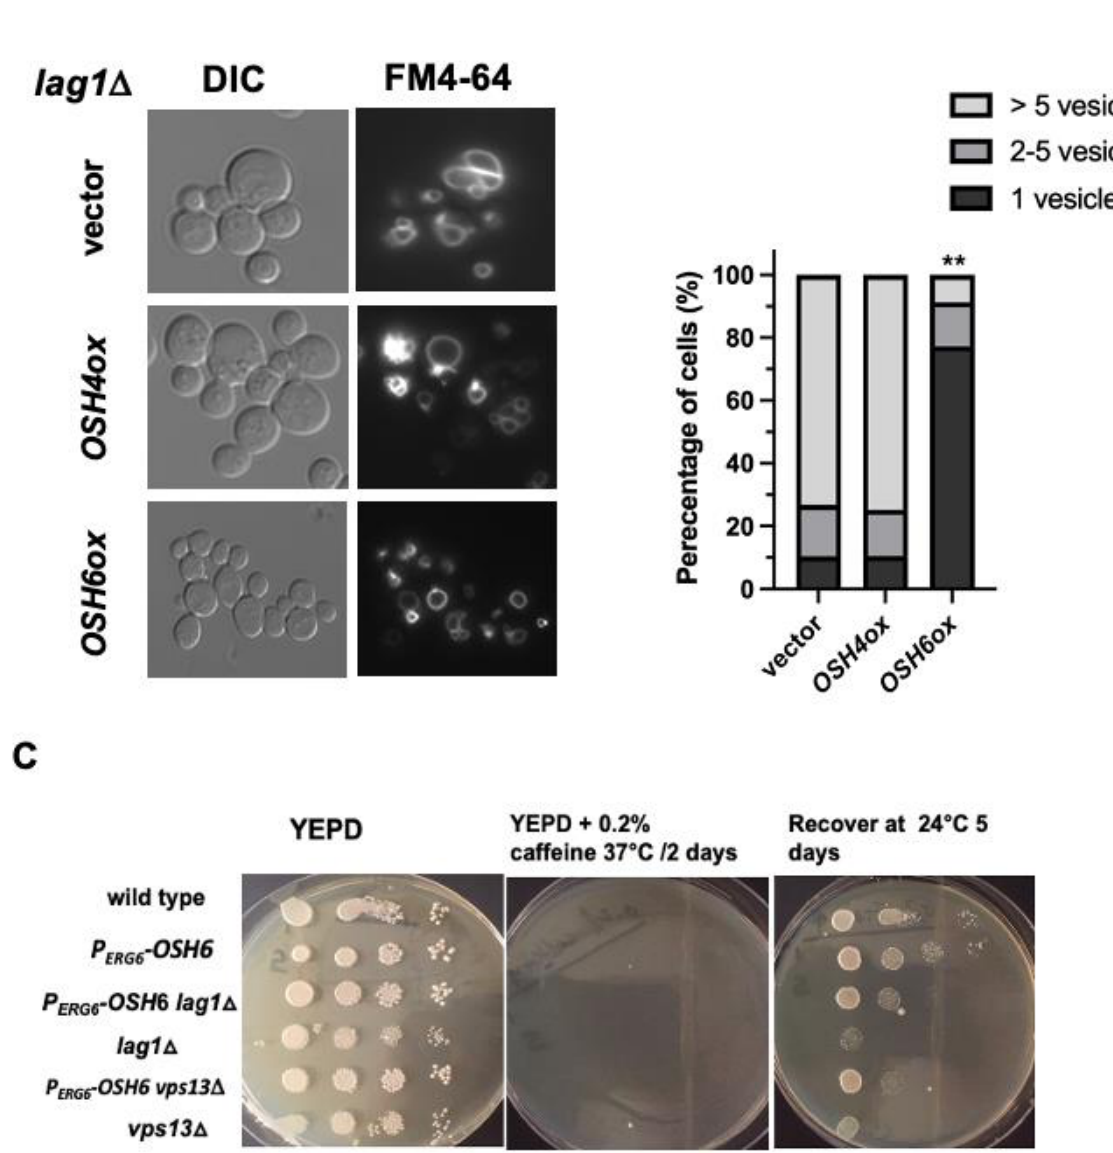
FIGURE 6: Up-regulation of OSH6 complements defects of lag1 ∆ . (A) Comparison of vacuole morphology of lag1 ∆ with the indicated plas- mids listed on the left. Vector: YEp24, OSH4 ox: YEp24- OSH4 ; OSH6 ox: YEp24- OSH6 . Log phase cells were labeled with FM4-64 for one hour and chased for three hours at 30 ℃ and then photographed. (B) Quantitation of cells with different categories of vacuoles. Sample sizes are 98 for lag1 ∆ (vector), 105 for lag1 ∆ ( OSH4 ox) and 102 for lag1 ∆ ( OSH6 ox). A one-way ANOVA shows that the fraction with one vacuolar vesi- cle/cell of lag1 ∆ ( OSH6 ox) is significantly higher than that of lag1 ∆ (vector) (p< 0.0001). (C) Recovery of cell growth after caffeine and high temperature arrest. Overnight cultures of wild type (BY4742), P ERG6 - OSH6 (FTY373), lag1 ∆ , P ERG6 - OSH6 lag1 ∆ (FTY527), vps13 ∆ , and P ERG6 - OSH6 vps13 ∆ (FTY534) were serially diluted by 10-fold (starting at 0.1 OD 600 /ml from the left). Five µl of serial diluted cells of the indicated strains were spotted on YEPD (left) and YEPD + 0.2% caffeine plate (middle) and incubated at 37°C for two days. Then the caffeine plate was incubated at room temperature (24°C) for five